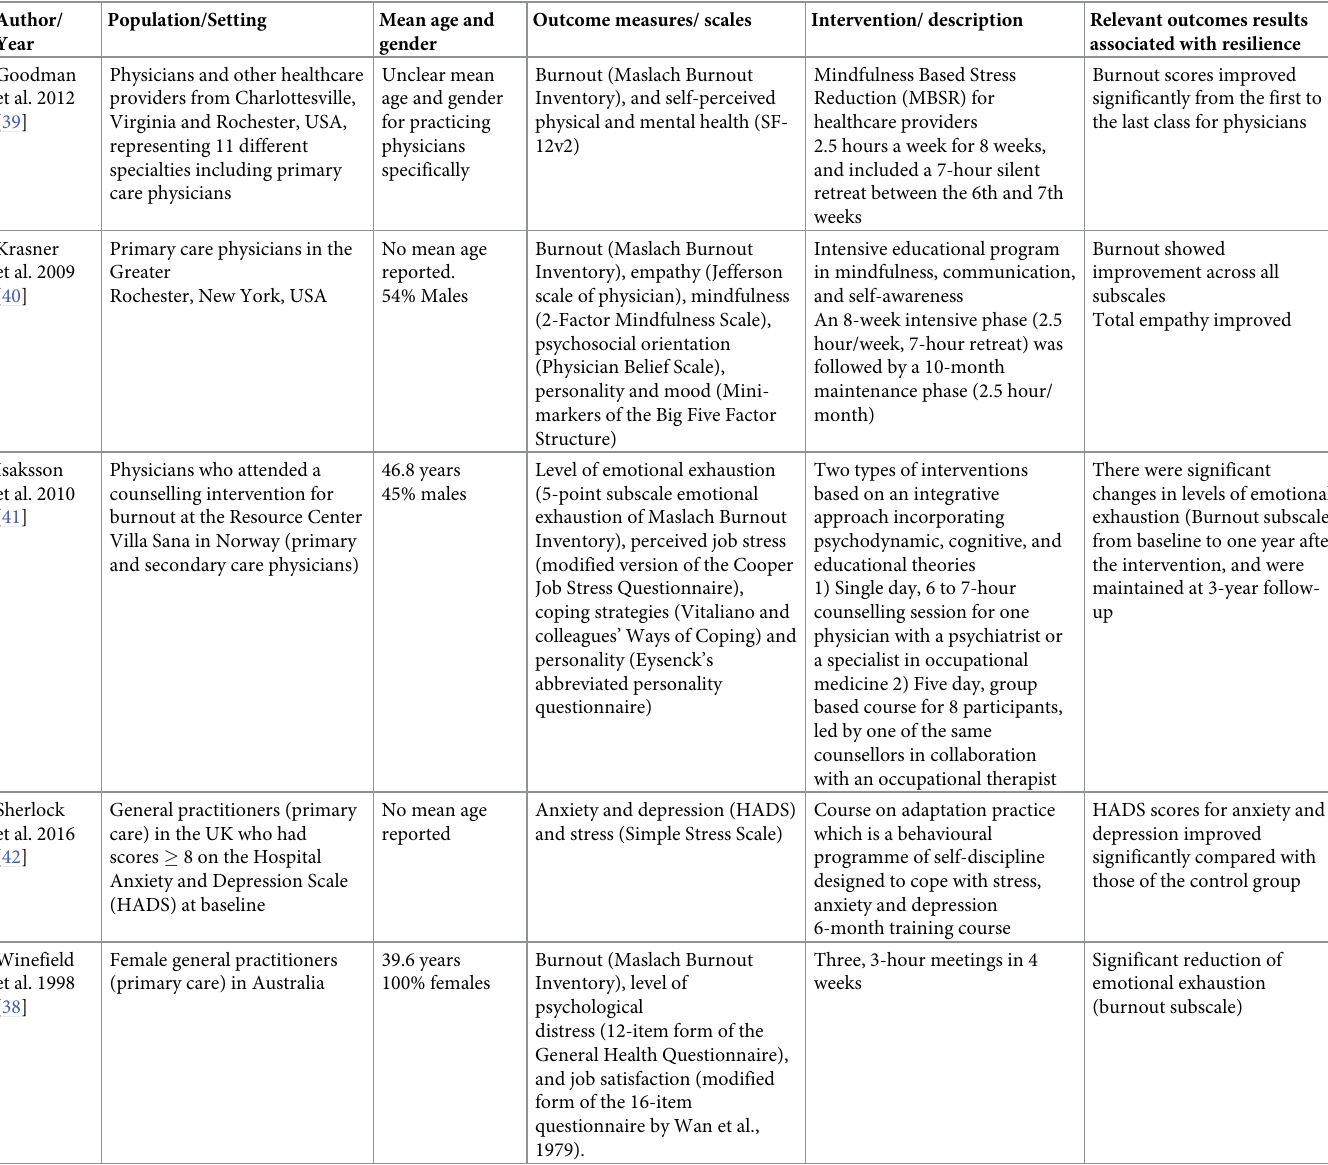
Table 2. Summary of clinical characteristics of studies including results specifically for physicians in observational